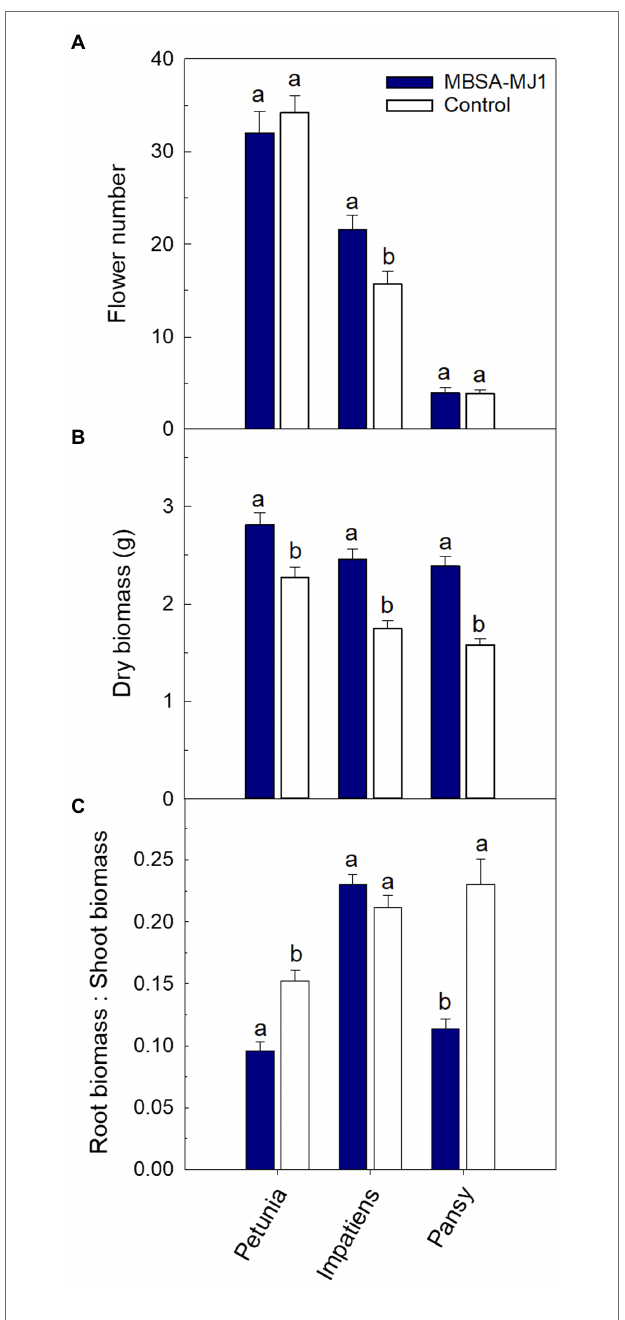
FIGURE 2 | Treatment with S. plymuthica MBSA-MJ1 influenced plant growth parameters for Petunia × hybrida (petunia), Impatiens walleriana (impatiens), and Viola × wittrockiana (pansy) plants grown under low-nutrient conditions. Plants were treated weekly with a media drench of S. plymuthica MBSA-MJ1 (blue bars) or uninoculated LB (control; white bars). Total number of flowers (A) and total shoot biomass (dry weight) (B) was measured 8 weeks post-transplant. The root:shoot ratio (C) was calculated with root and total shoot dry weights. Bars represent mean (±SE) with different letters representing significant differences ( p < 0.05), and n = 13 for petunia, n = 14 for pansy, and n = 18 for